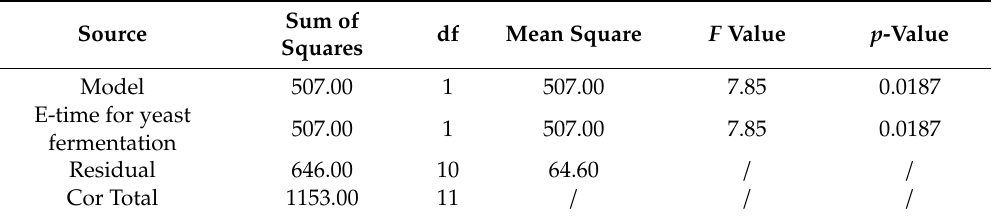
Table 5. Analysis of variance (ANOVA)of the e ff ect of the studied parameters upon the antifungal activity of the fermented products.